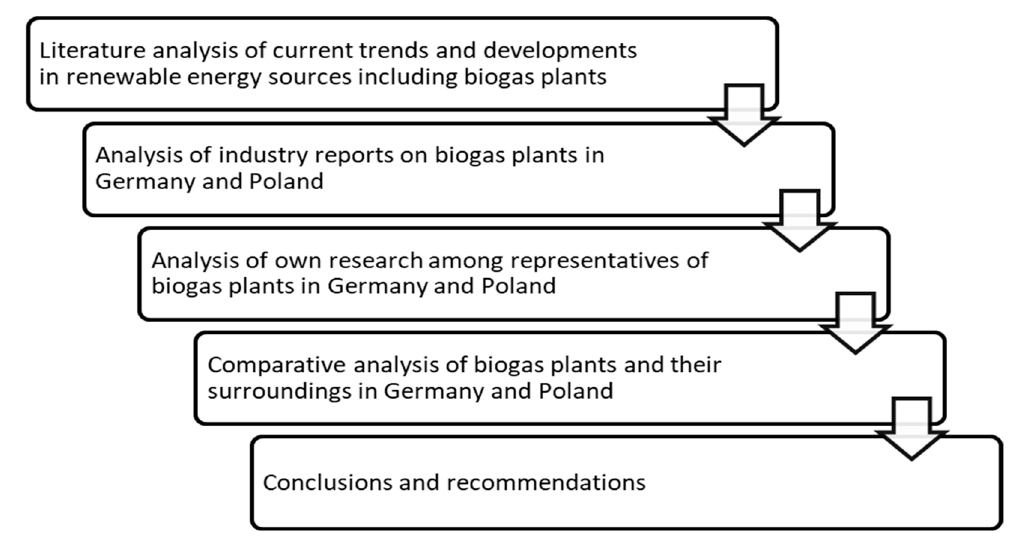
Figure 1 . Research algorithm—own study. Figure 1. Research algorithm—own